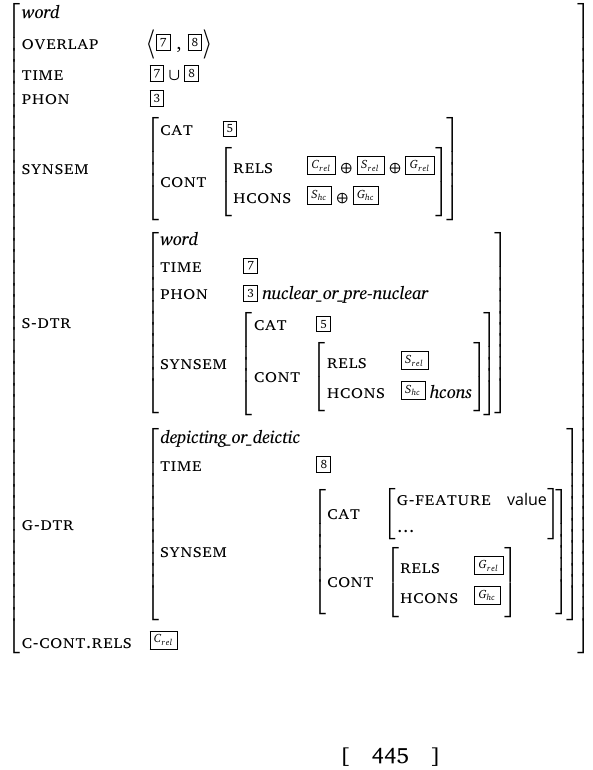
Figure 5: hpsg-based formalisation of the Situated Prosodic Word Constraint aligning gesture and a spoken